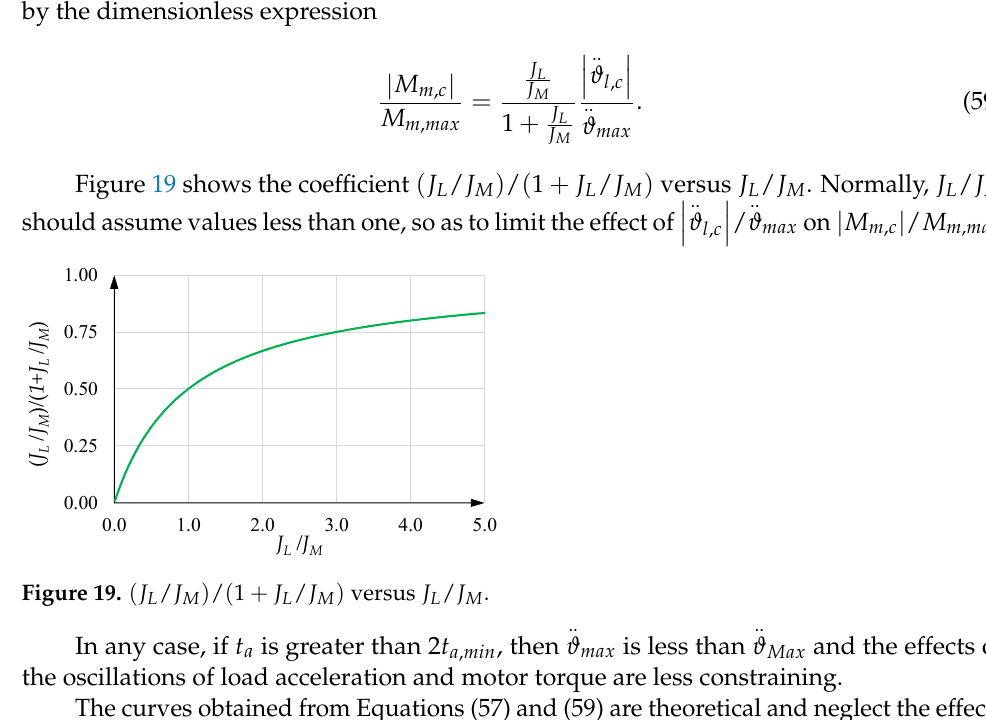
(cid:12) (cid:12) .. .. (cid:12) (cid:12) f f when the load acceleration reaches its peak within Figure 18. ϑ ϑ   versus Figure 18. ϑ l , c ϑ max versus f n / f n , e when the load acceleration reaches its peak within t c , with k j (cid:12) (cid:12) / n n,e l,c max equal to one and two. with equal to one and two. M denotes the quantity, If m,max